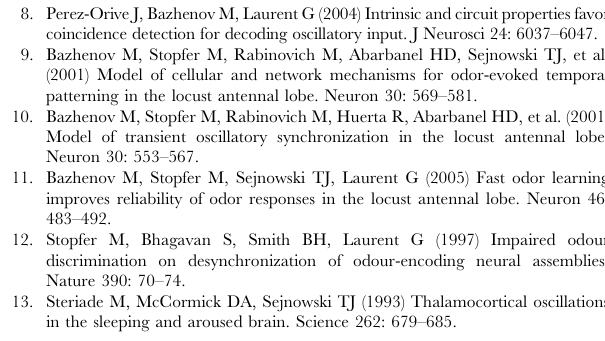
Figure S1 SRDP and the persistence of olfactory representa- tions. Data are represented as in Figure 5. Columns indicate different learning protocols under SRDP. From left to right: ‘‘naı¨ve’’; learning on a test odor alone (e.g., ‘‘1111’’); sequential learning on combinations of four different odor blocks (e.g., ‘‘2143’’); ‘‘RANDOM,’’ learning on the sequence of randomly permuted single 1-s trials of the odors 1, 2, 3, and 4. Rows indicate the test odor for the olfactory circuits above (odors 1–4 were included in the learning sequence; odor 6 was not included in the learning sequence). For each spike count bar plot, the sparseness measure is indicated in the upper left corner (N/A: not available, less than 1/4 of 1-s trials elicited on average at least one spike), whereas the Euclidean distance in 19-D KC odor space from the average representation after learning on a test odor alone is indicated in the upper right corner (multiple odor sequences